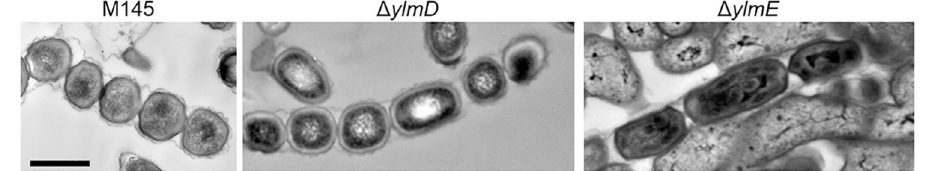
Figure 4. Transmission electron micrographs of spores of S. coelicolor M145 and its ylmD and ylmE mutants. Wild-type spores (M145) show regular sizes and appearance ( A ). In contrast, spores of the ylmD ( B ) and ylmE ( C ) null mutants have an irregular appearance. Note the lighter appearance of the spore wall in the ylmD null mutant and the lack of the typical thick spore wall in ylmE mutants. Cultures were grown on SFM agar plates for 5 days at 30 °C. Bar, 500